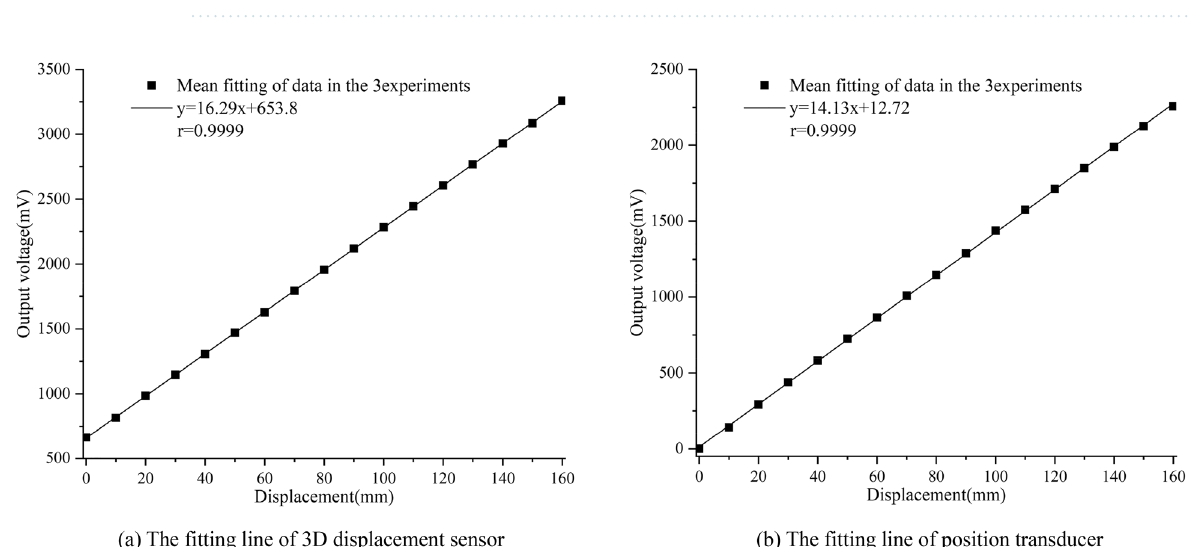
Figure 17. Linear fitting line of output voltage value and displacement (( a , b ) were generated by Origin 2016 × 64 (https:// www. origi nlab. com/